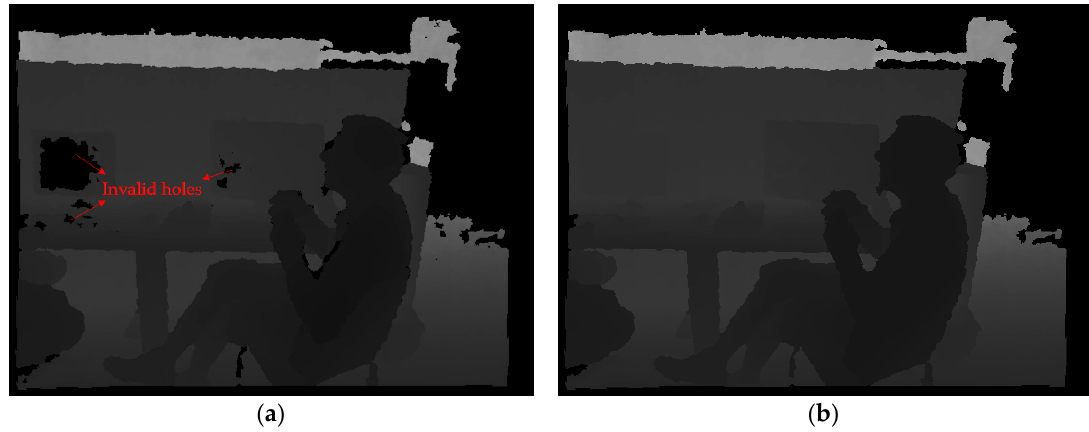
Figure 3. Original depth image and filled depth image. ( a ) There were some no data holes in the original depth image; ( b ) filled depth image. No data holes in the depth image were filled after this step.